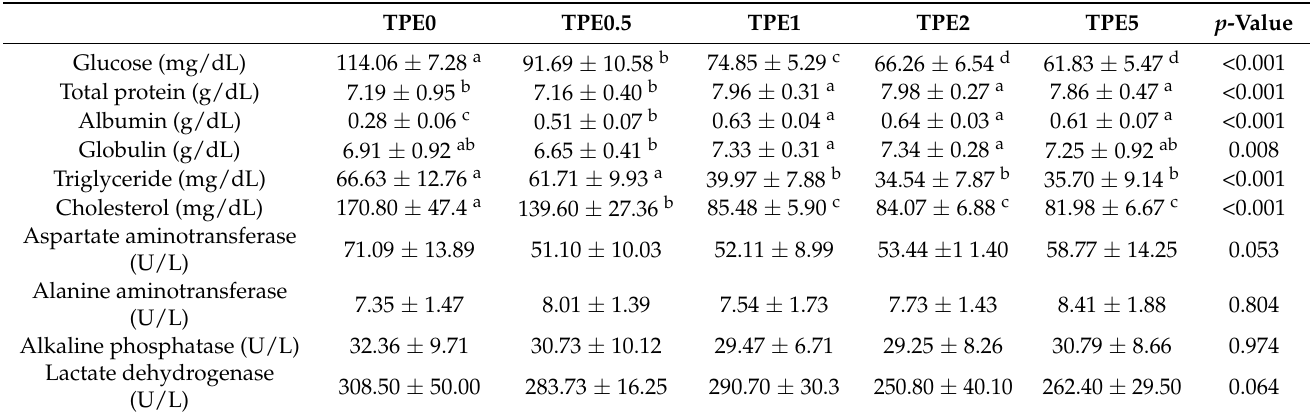
Table 5. Blood biochemical parameters of Cyprinus carpio fed with experimental diets supplemented with different ratios of tomato paste by-product extract